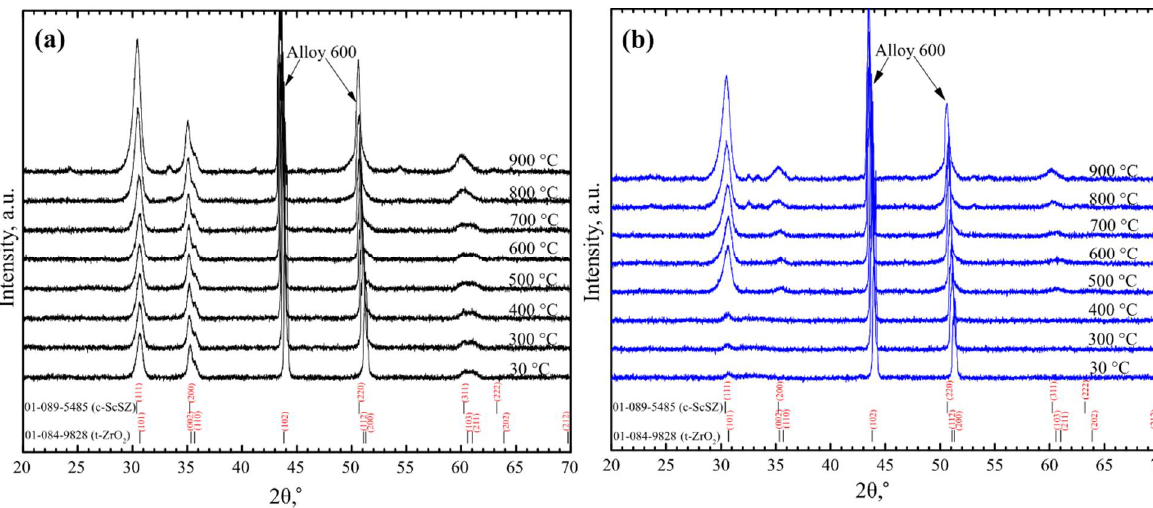
Figure 6. XRD patterns of ScAlSZ thin films during annealing process containing different Al concentration: ( a ) 15.9 at.% and ( b ) 22.2 at.%.